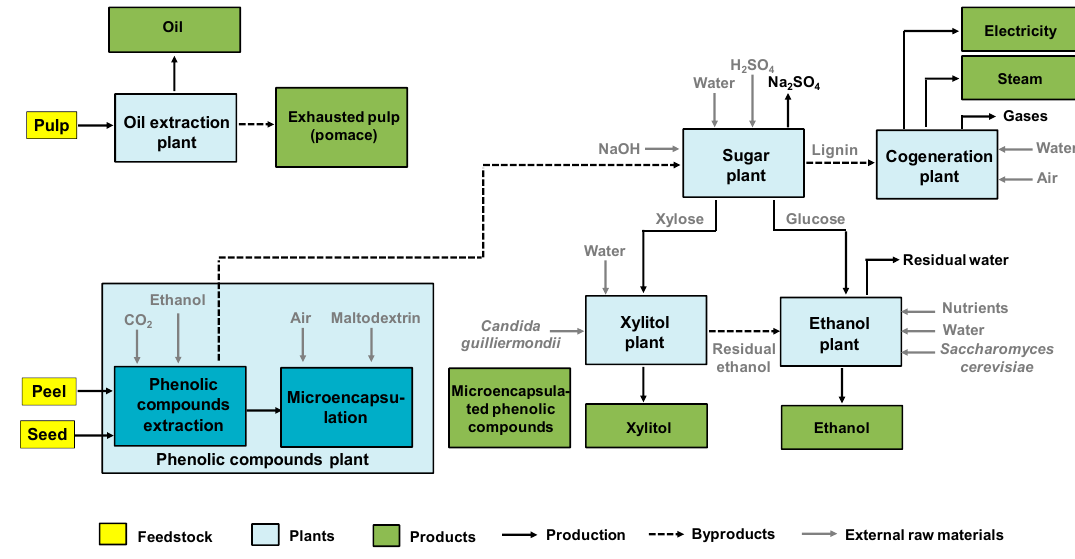
Figure 11. Scheme of a biorefinery proposal based on avocado [31].